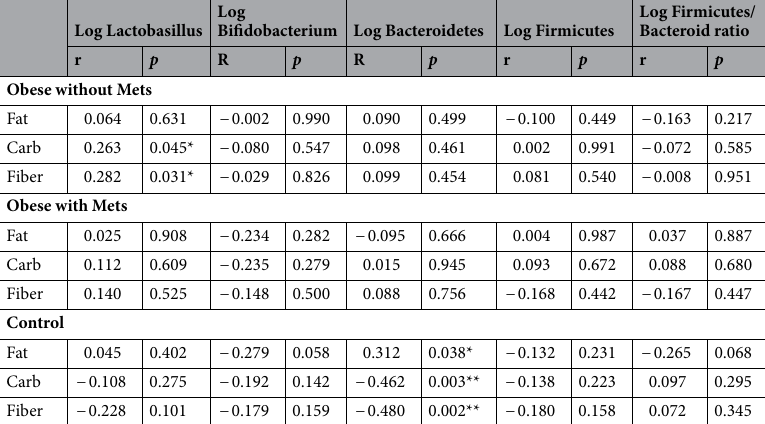
Log Firmicutes/ Bacteroid